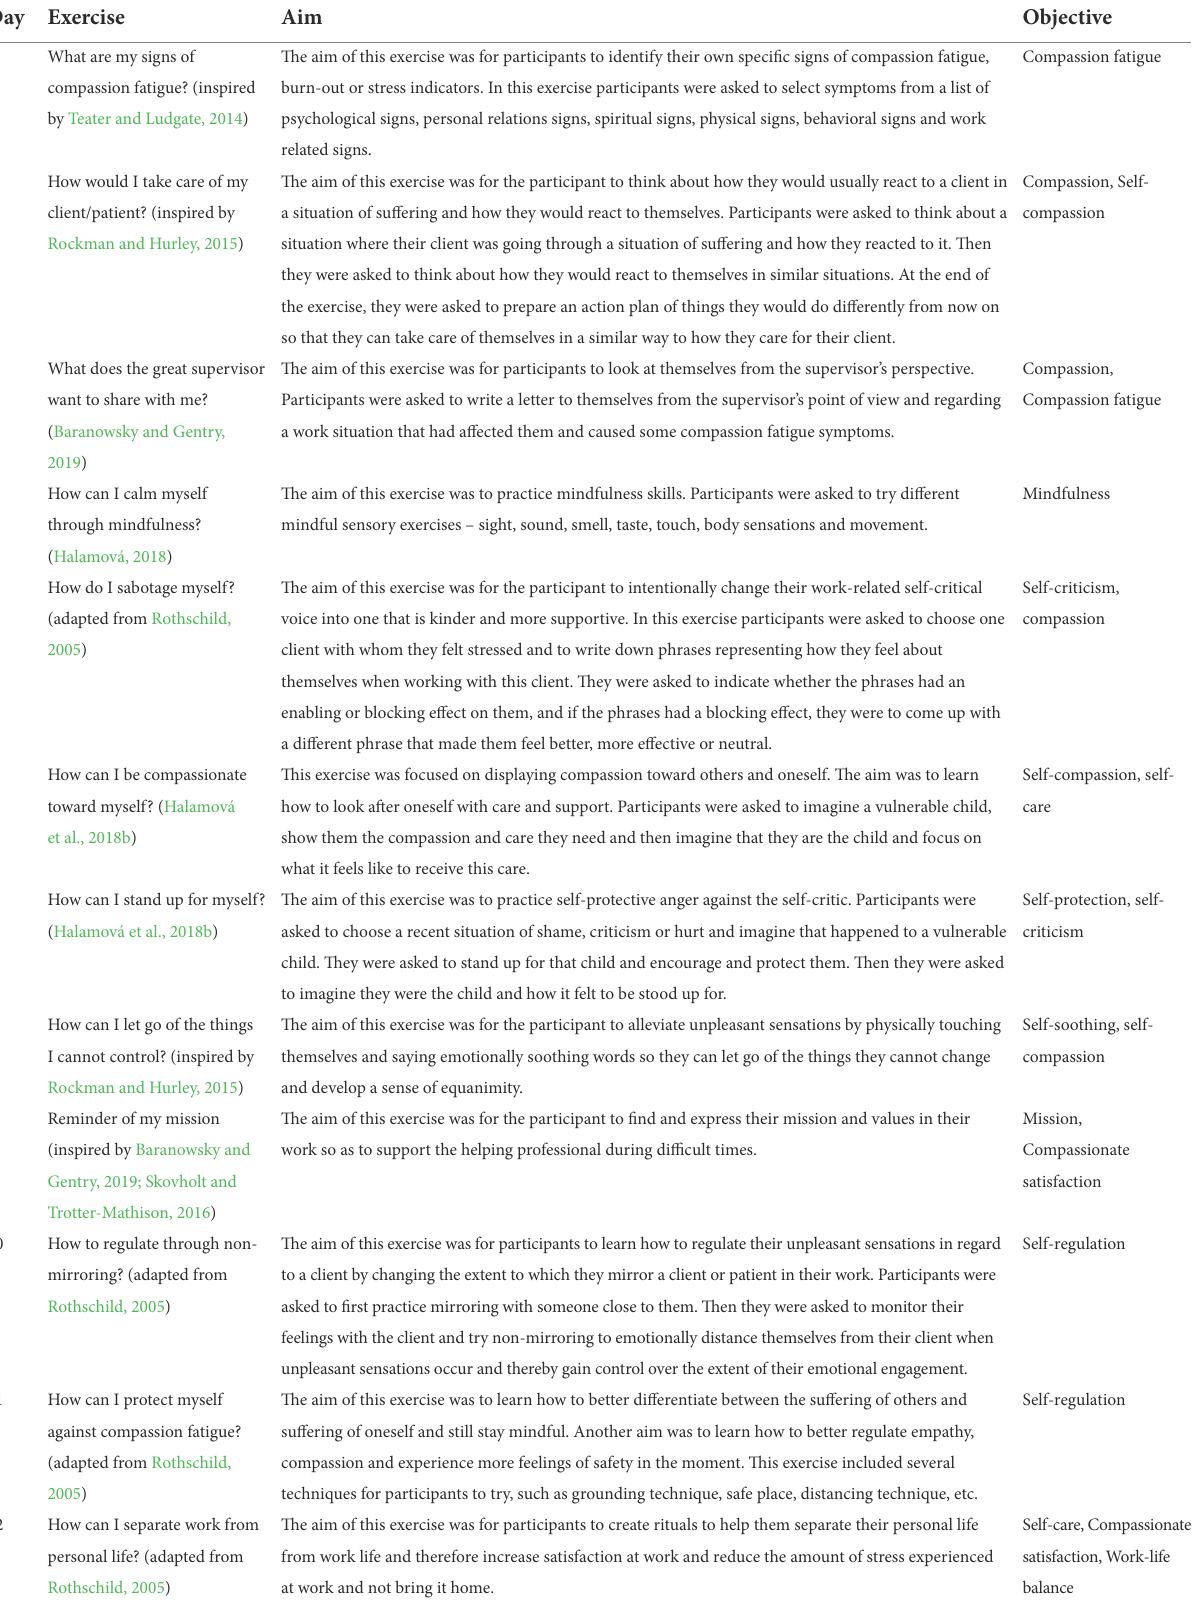
TABLE 1 Emotion focused training for helping professionals. Day Exercise